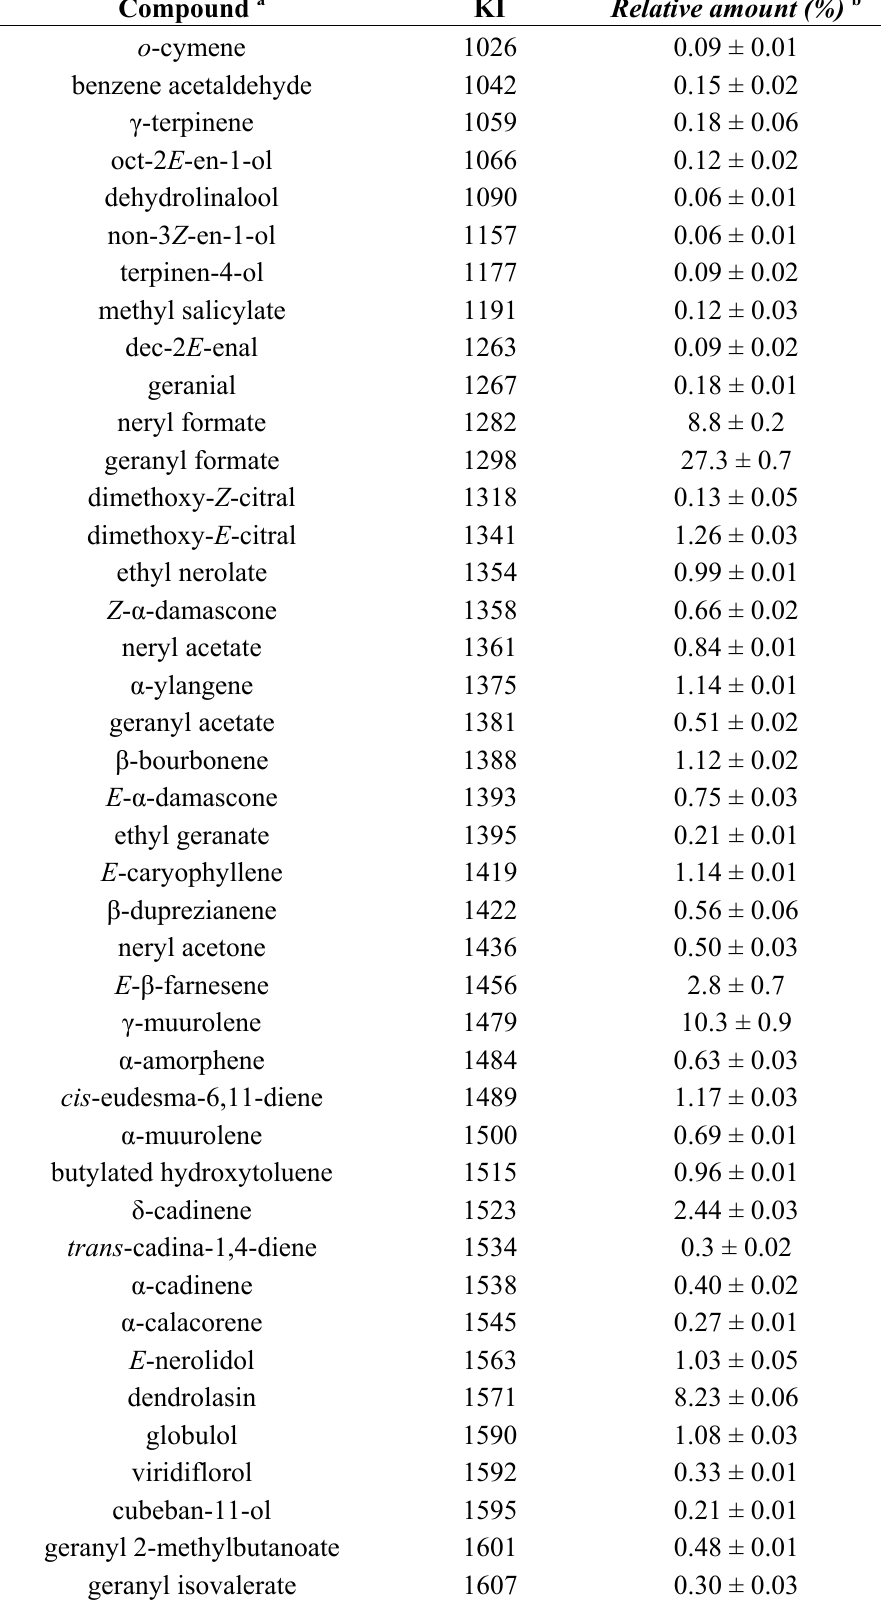
Table 2. The chemical composition of essential oils obtained from the ripe fruit of Porcelia macrocarpa (November